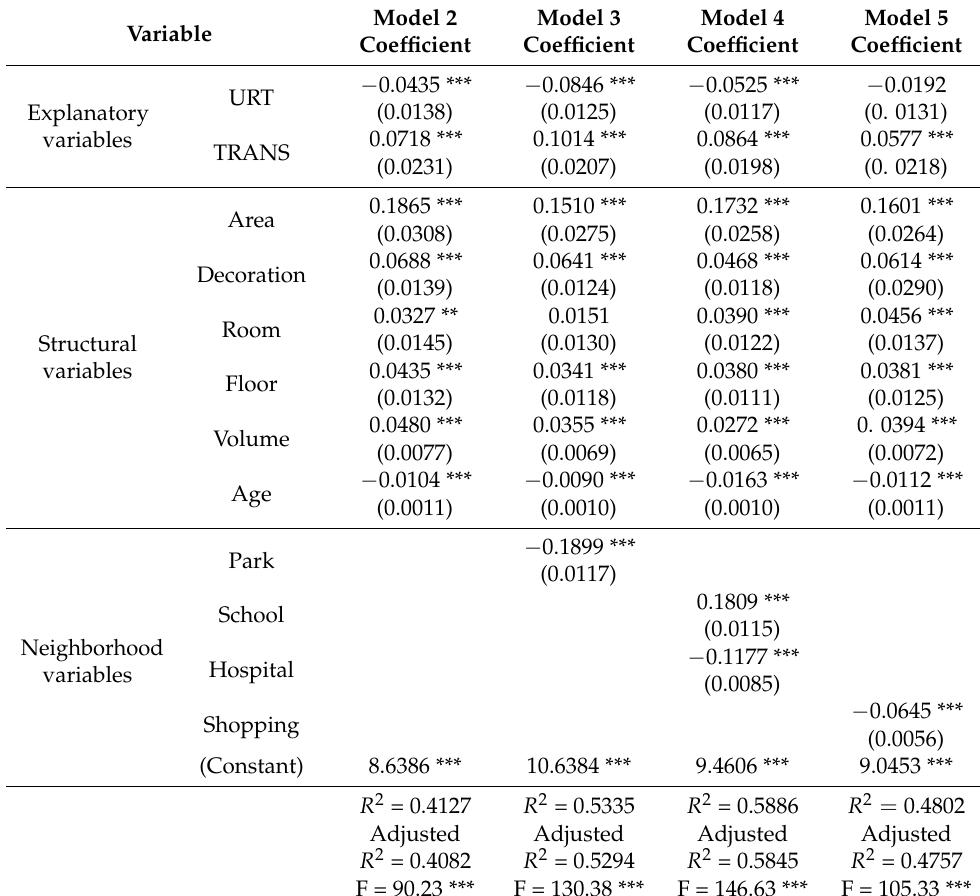
Table 3. The results of the effects of URT and single-dimension neighborhood infrastructures on property